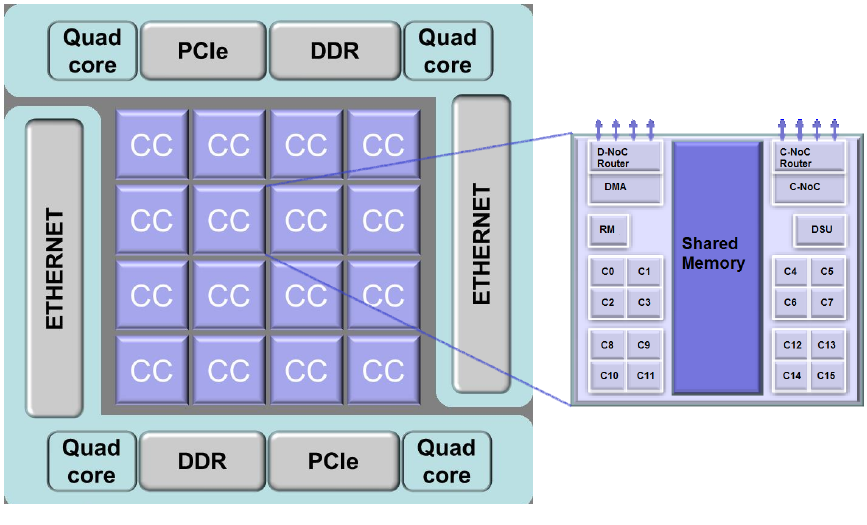
Figure 7. Many-core processor components. CC: Compute Cluster. DDR: Double Data Rate memory. PCIe: Peripheral Component Interconnect express. D-Noc: Data Network-on-Chip. C-Noc: Control Network-on-Chip. DMA: Direct Memory Access. DSU: Debug Support Unit. RM: Resource